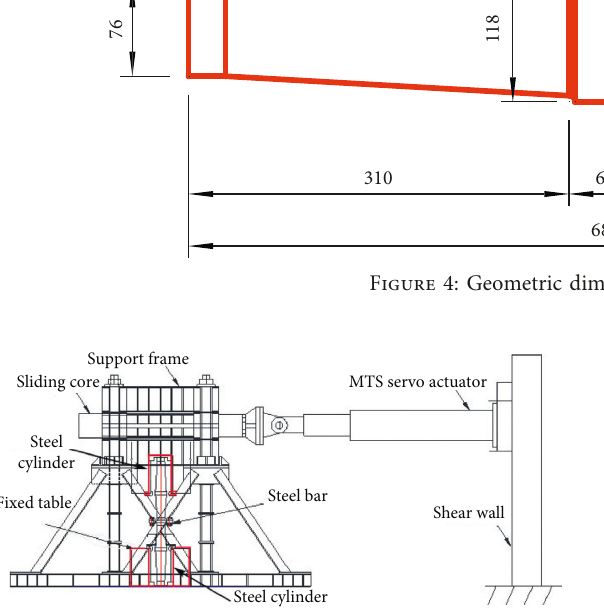
Figure 5: Schematic diagram of the experimental device.